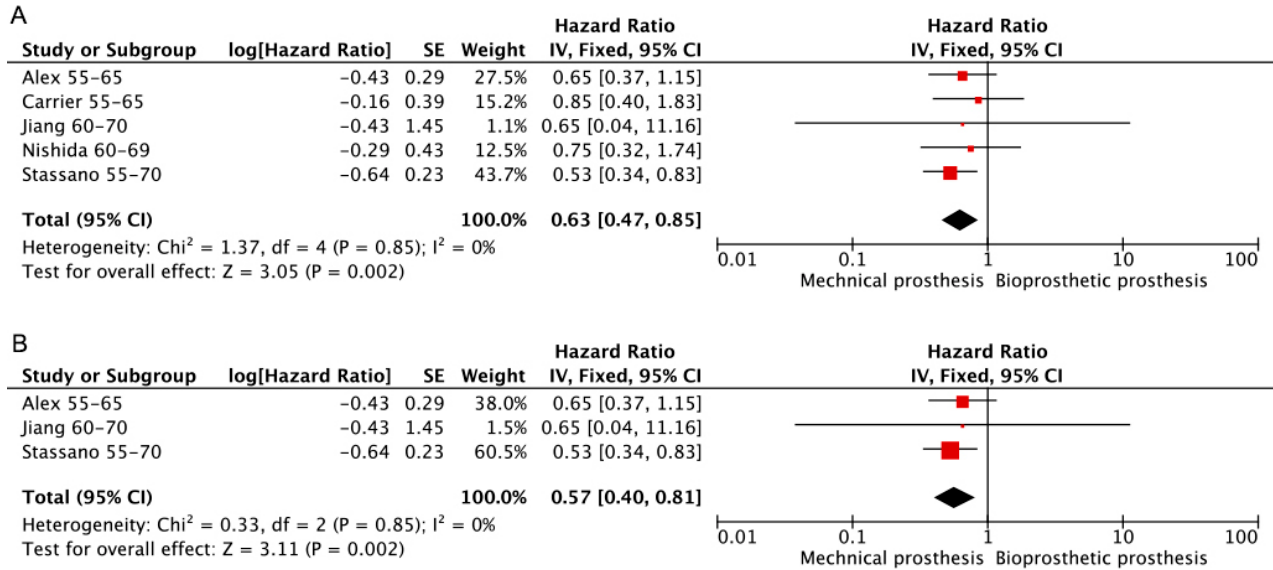
Figure 6. Meta ‐ analysis for freedom from valve ‐ related events. ( A ) Bioprosthetic vs. mechanical. ( B ) Figure 6. Meta-analysis for freedom from valve-related events. ( A ) Bioprosthetic vs. mechanical. Bioprosthetic vs. mechanical (RCT or PSM). ( B ) Bioprosthetic vs. mechanical (RCT or PSM).